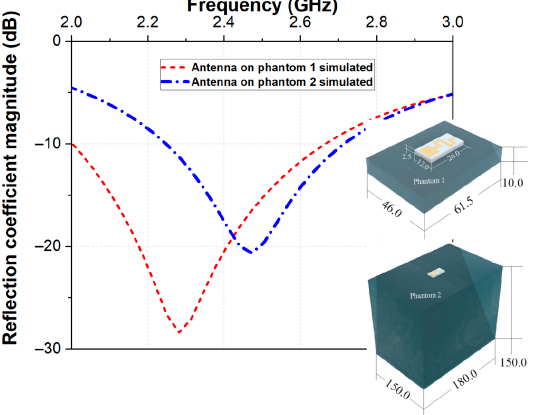
Figure 3. Simulated reflection coefficient magnitude versus frequency when the proposed antenna was placed on the Phantom 1 and Phantom 2.